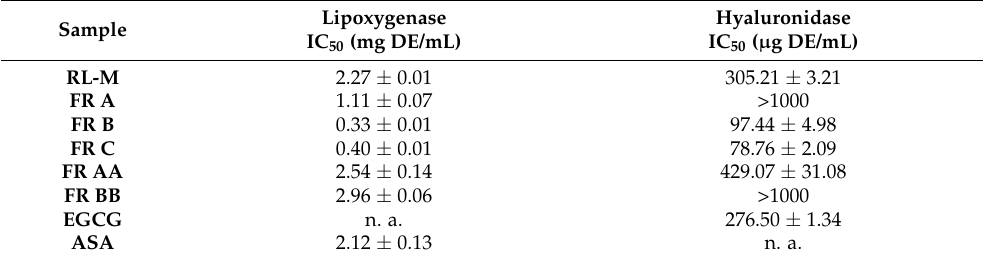
Table 3. Antihyaluronidase and antilipoxygenase activity of polyphenolic fractions from Rhododendron luteum Sweet leaves. The inhibition of enzymes is expressed as the IC 50 value (concentration of the sample which causes 50% inhibition). Abbreviations: n. a.—not analyzed, EGCG—epigallocatechin gallate, ASA—acetylsalicylic acid, other abbreviations as in Table